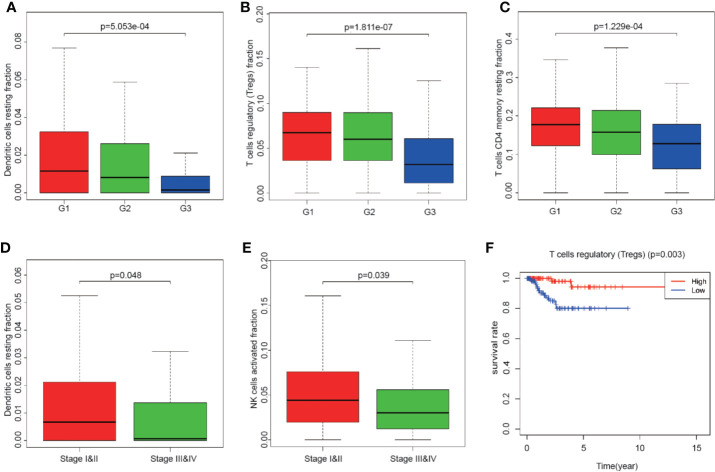
The relationship between clinical characters and overall survival with the fraction of tumor-infiltrating immune cells. (A–C) The relationship of the fraction of tumor-infiltrating immune cells and EEA clinical grades; (D, E) The relationship of the fraction of tumor-infiltrating immune cells and EEA clinical stages; (F) Kaplan–Meier survival curve for the abundance ratios of tumor-infiltrating immune cells.